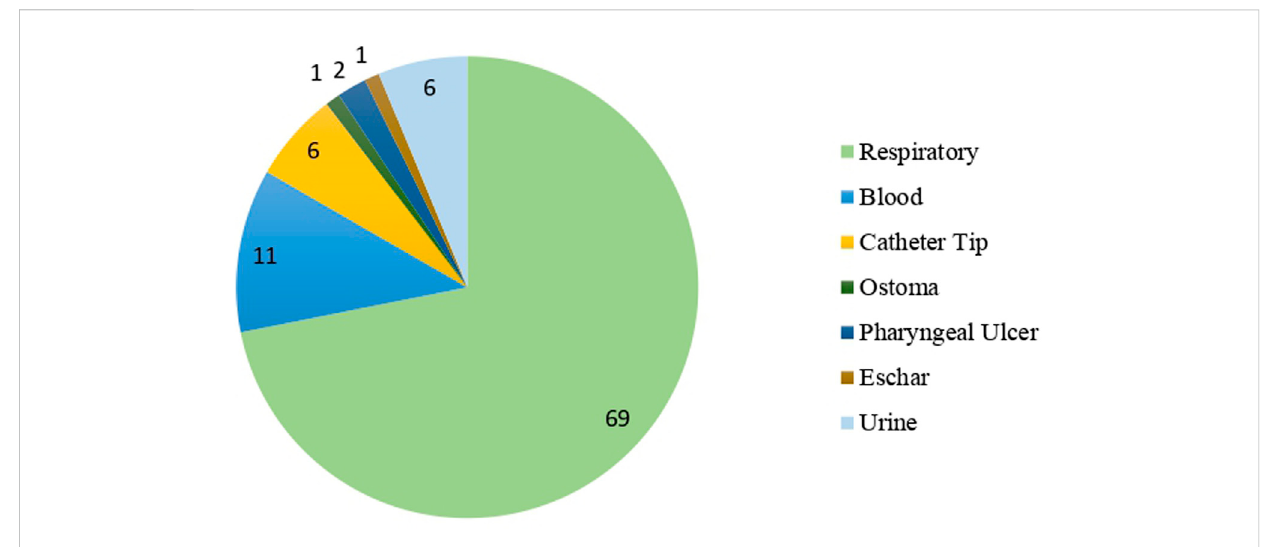
Other samples included blood (11 samples, 9.6%), a catheter (6 samples, 5.2%), and urine (6 samples, 5.2%), among others (Figure 2).